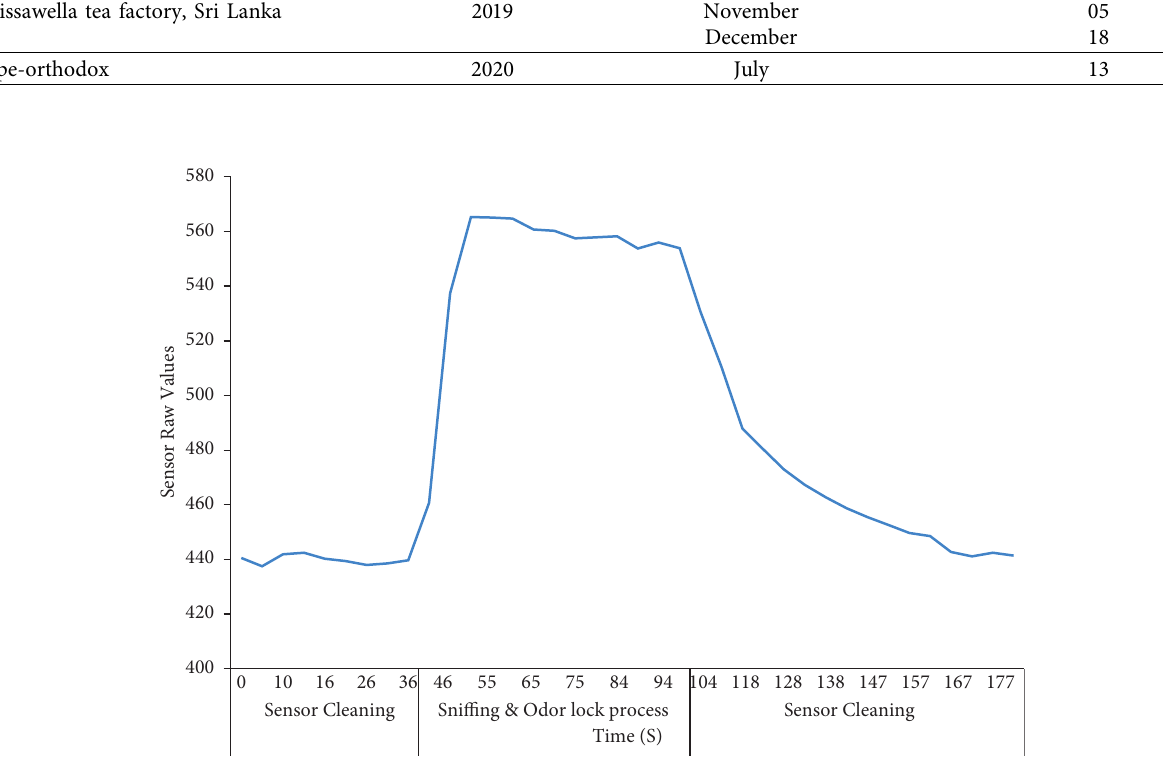
Figure 2: A sample single sniffing cycle of the Digi-Nose system